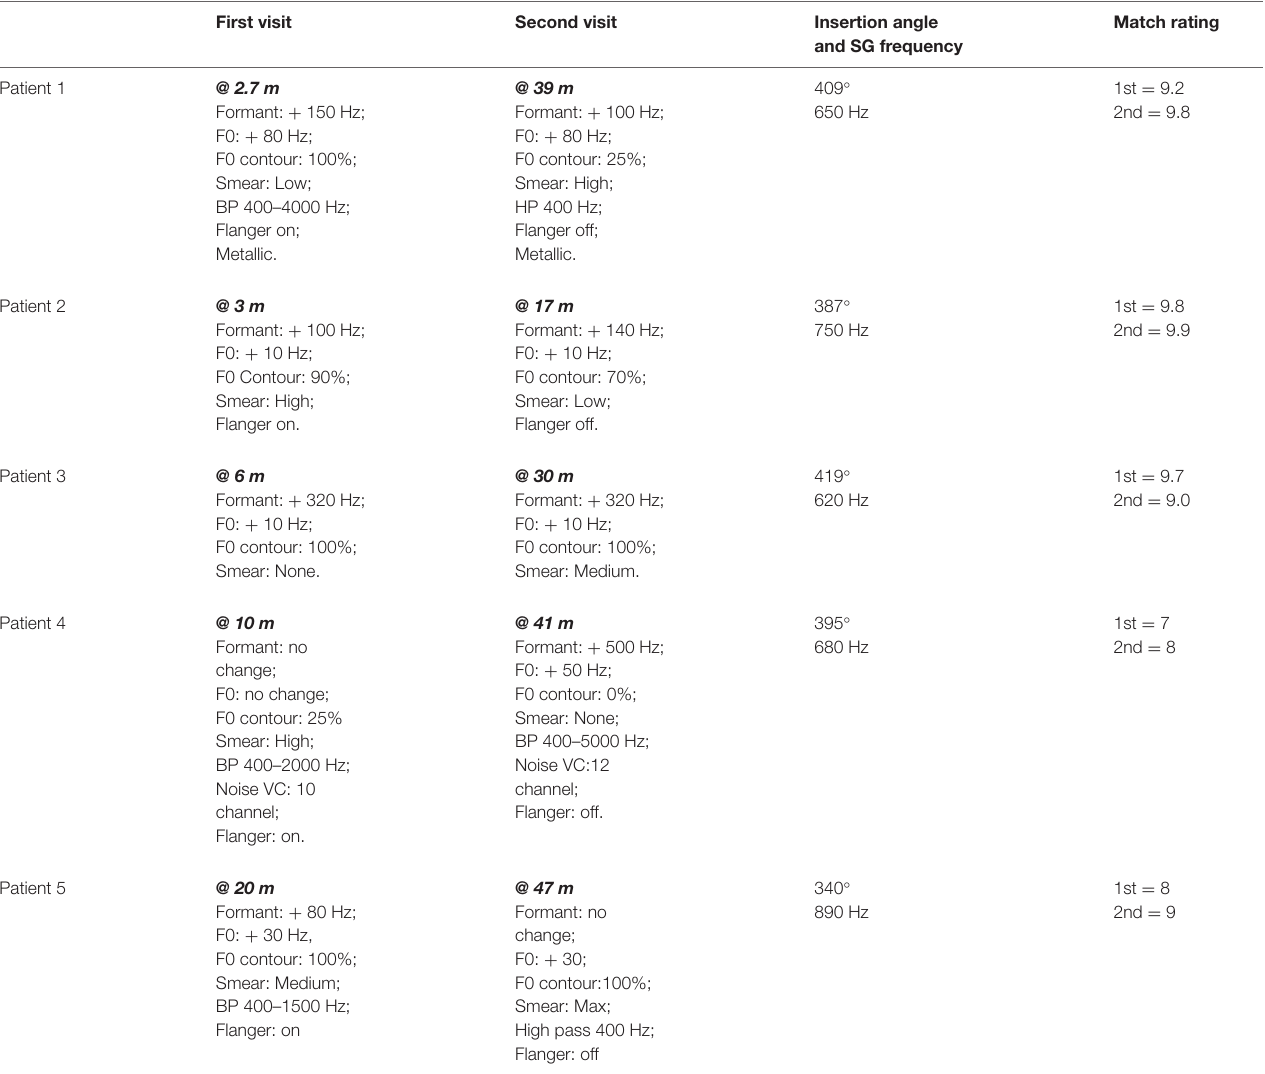
TABLE 2 | Stimulus alterations needed to match CI sound quality at Time 1 and Time